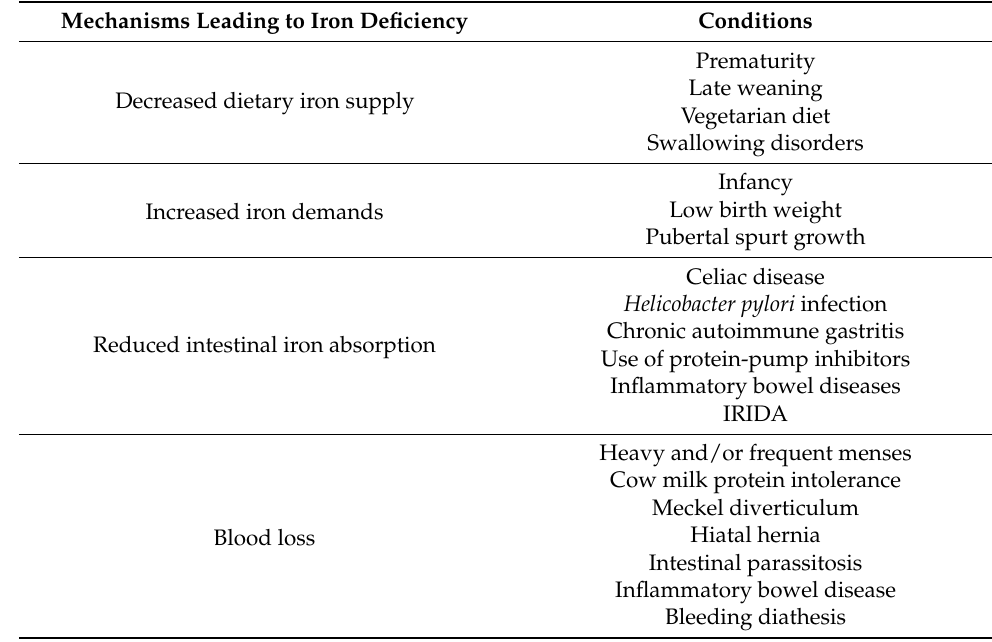
Table 1. Causes of iron deficiency anemia